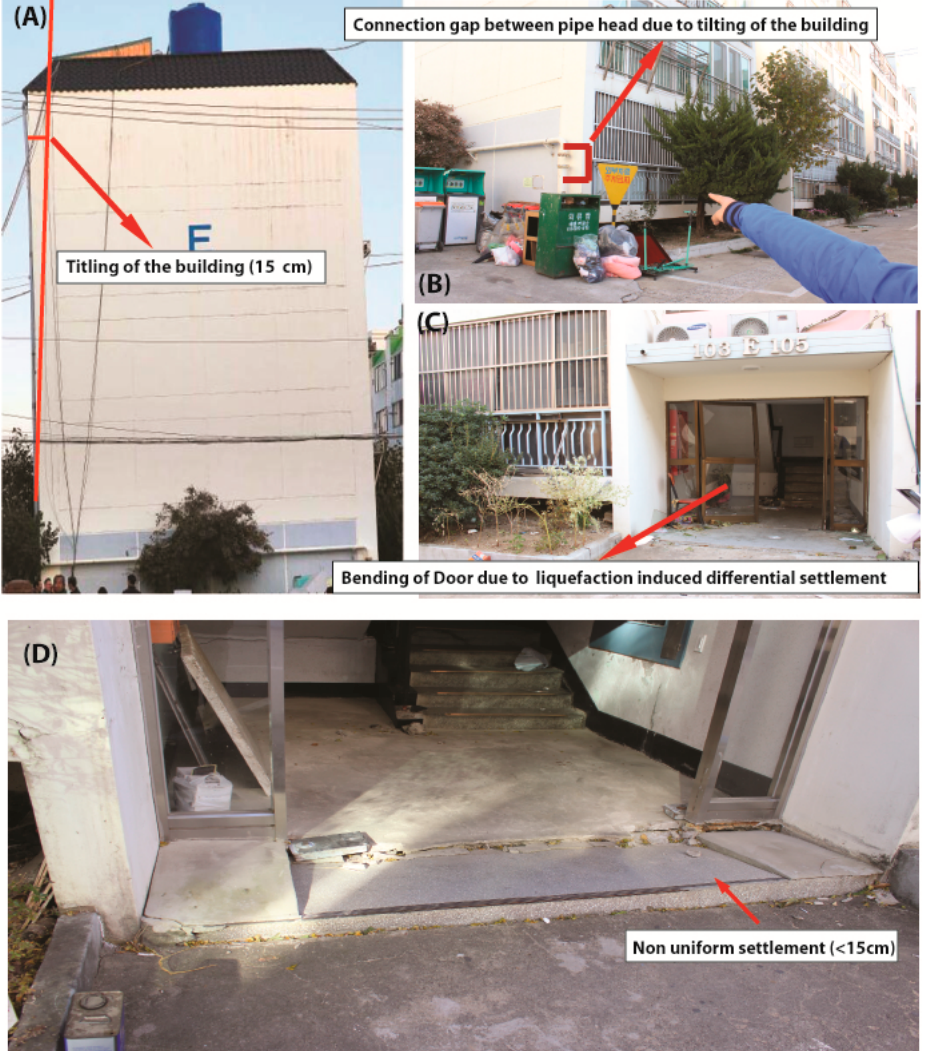
Figure 8. Photographs showing ( A ) a titled residential building due to differential settlement (the building was titled about 15 cm); ( B ) separation of water pipeline due to titling of the building; ( C ) and ( D ) differential settlement observed in the basement of the residence buildings in the epicentral area (he basement of the building settled almost 15–30 cm).